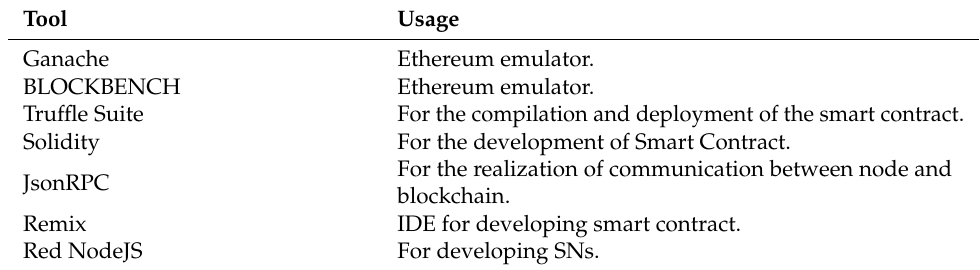
Table 3. Tools used in the